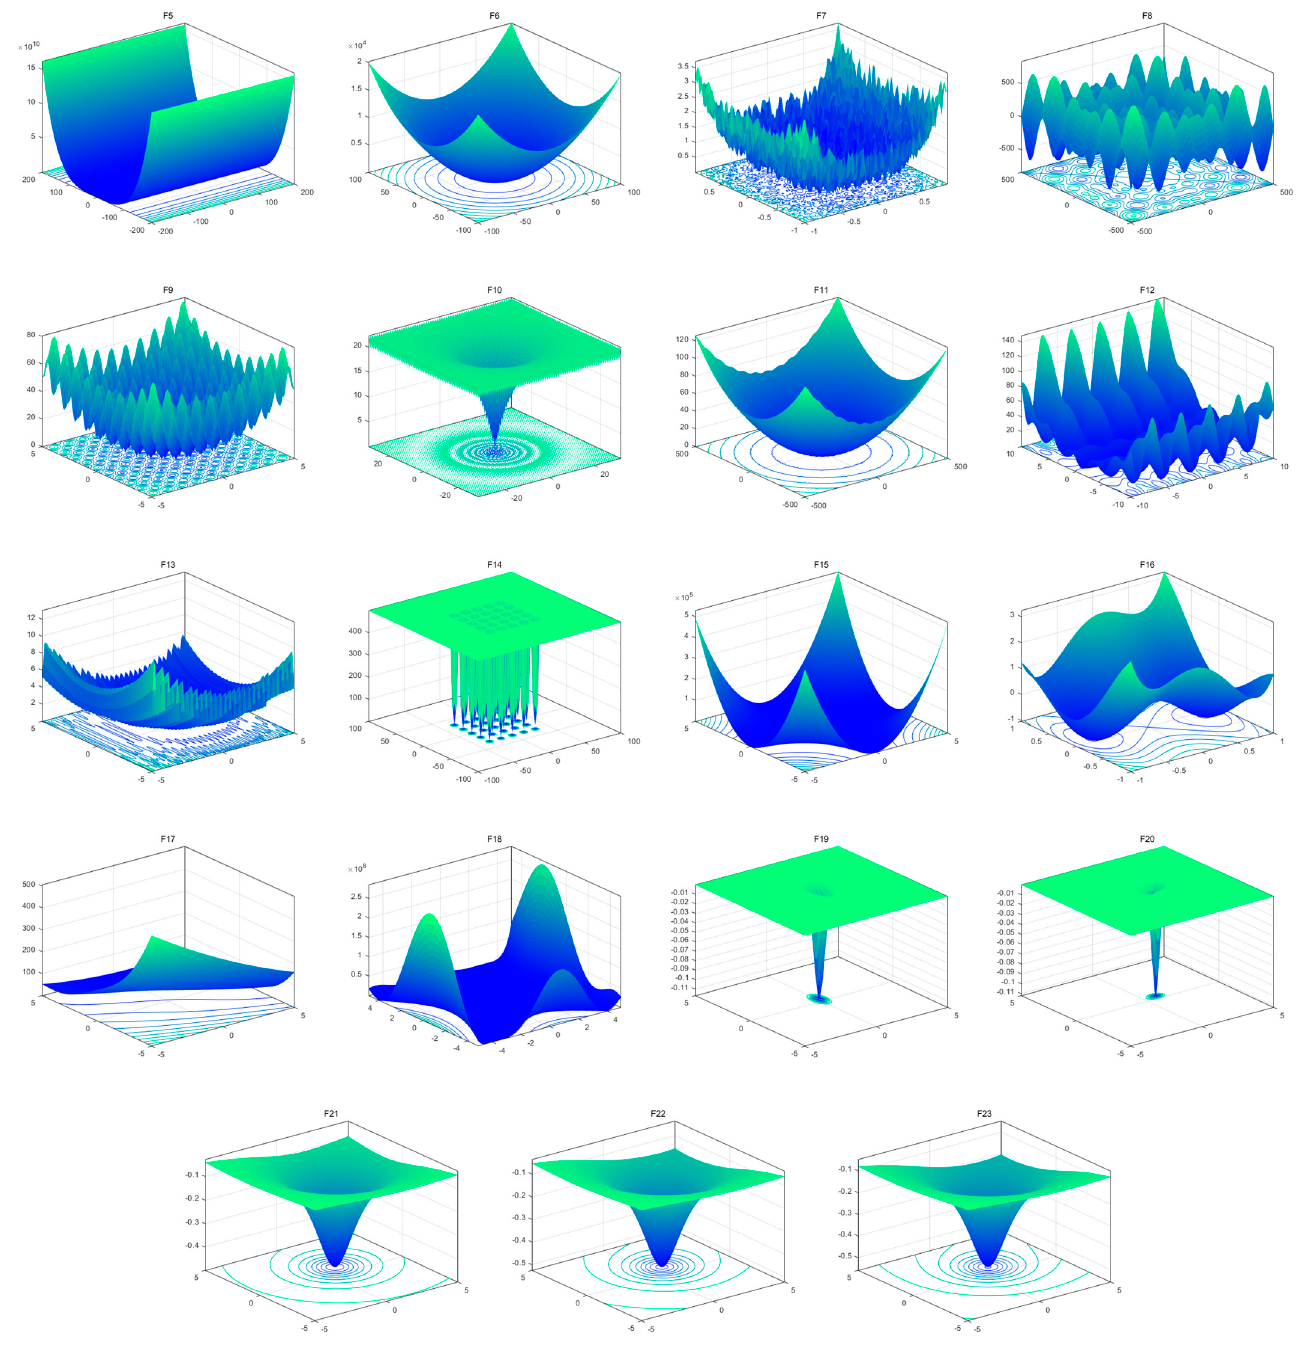
Figure 5. View of 23 benchmark functions. Table 1. Definition of 23 benchmark functions.